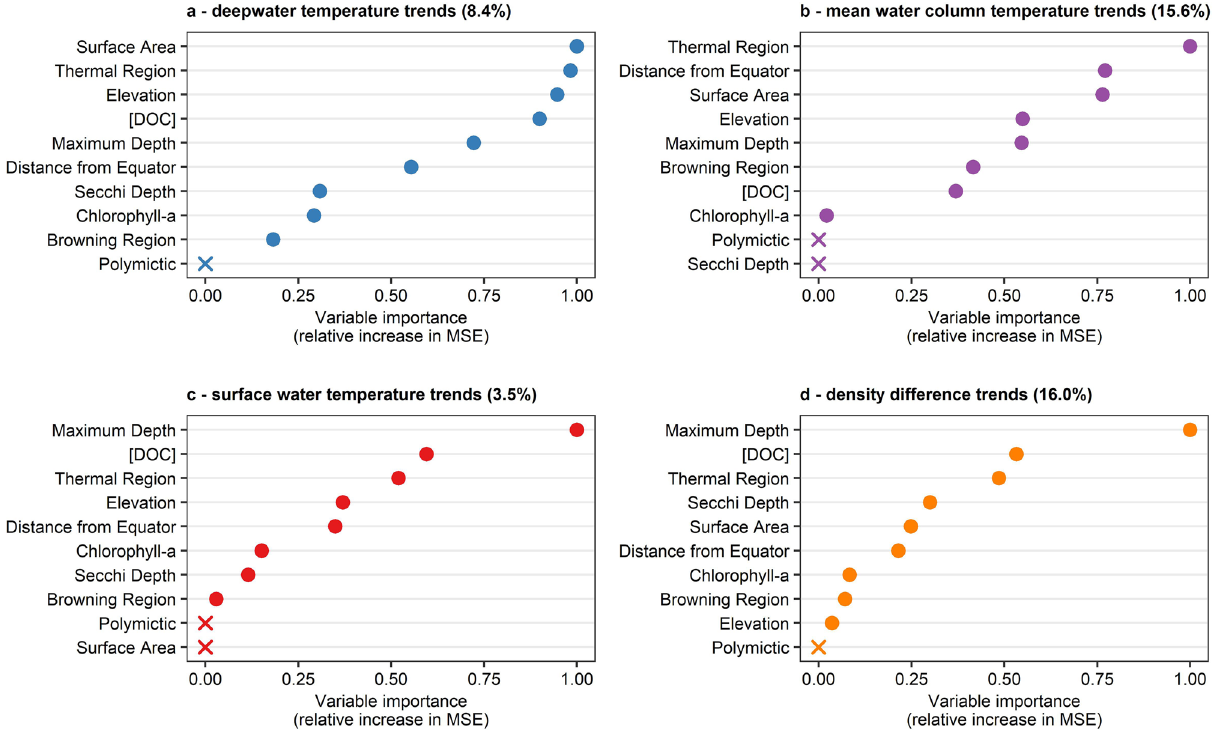
Figure 4. Relative variable importance plots from random forest analysis for thermal metric trends. Relative variable importance for ( a ) deepwater temperature trends, ( b ) mean water column temperature trends, ( c ) surface water temperature trends, and ( d ) density difference trends. Solid circles in each panel indicate the relative increase in mean squared error (MSE) due to a random permutation compared to the most important variable, in order of decreasing importance. Variables marked with “X” had no increase in MSE and are statistically equivalent to random prediction. Random forest for thermocline depth resulted in 0% explanatory power, so no additional analysis was